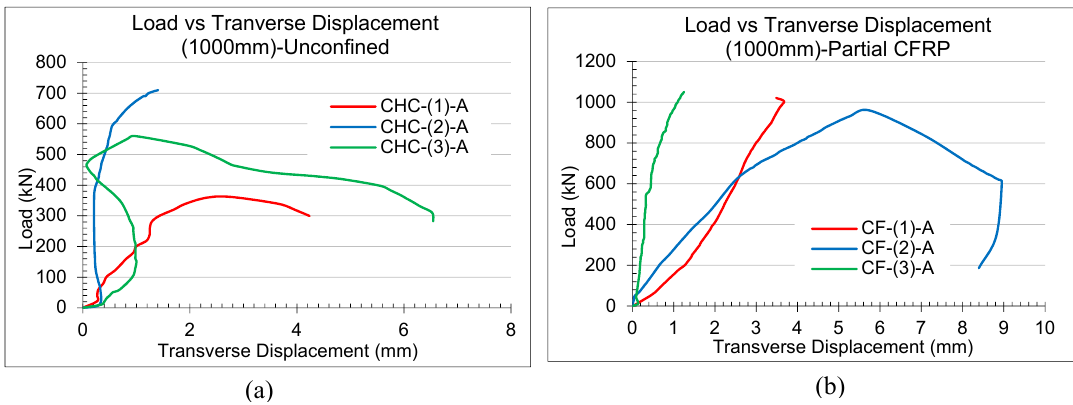
Figure 4. Load vs Vertical Displacement; (a) Unconfined CHRCC (b) Partial CFRP CHRCC.